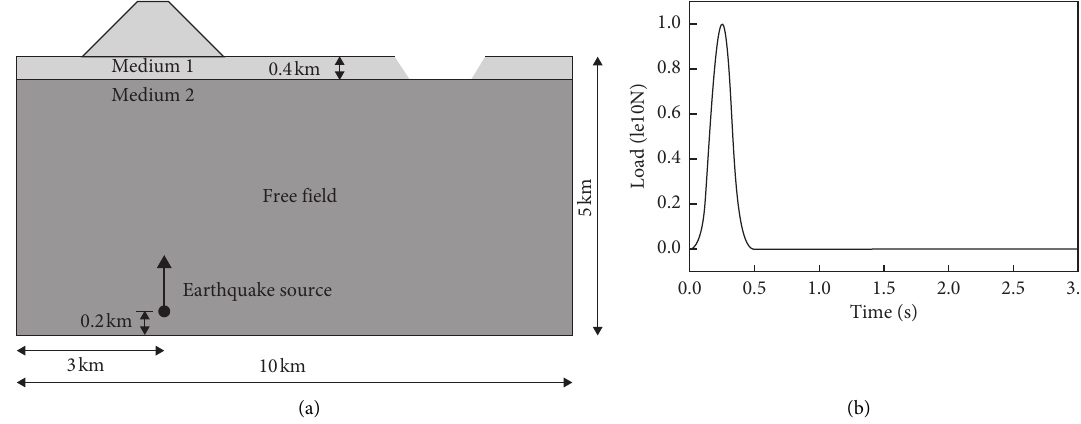
Figure 18: The complex layered source-site model and load history: (a) the layered source-site model, (b) load